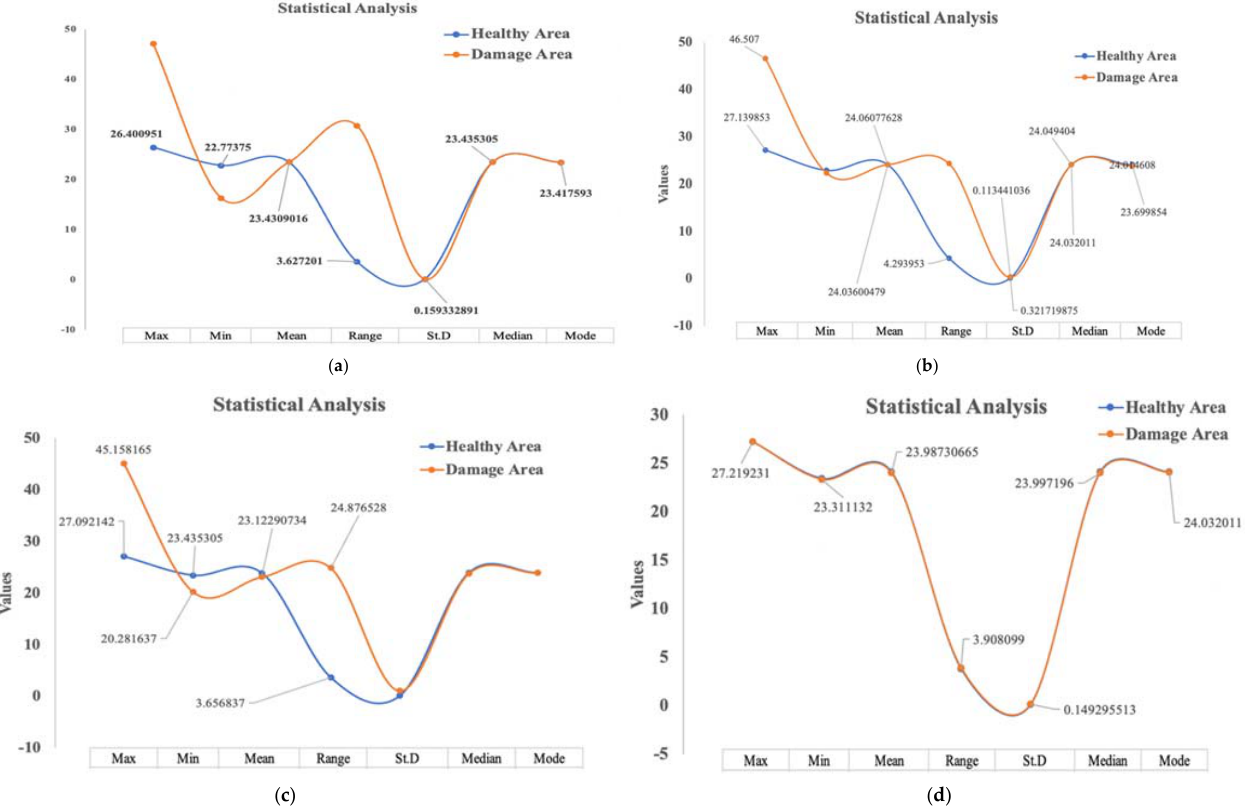
Figure 12. Statistical Analysis results. ( a ) Healthy thin vs. damaged area based on reflection mode. ( b ) Healthy thick area vs. damaged area based on reflection mode. ( c ) Healthy thin area vs. damaged area based on transmission mode. ( d ) Healthy thick area vs. damaged area based on transmission mode.